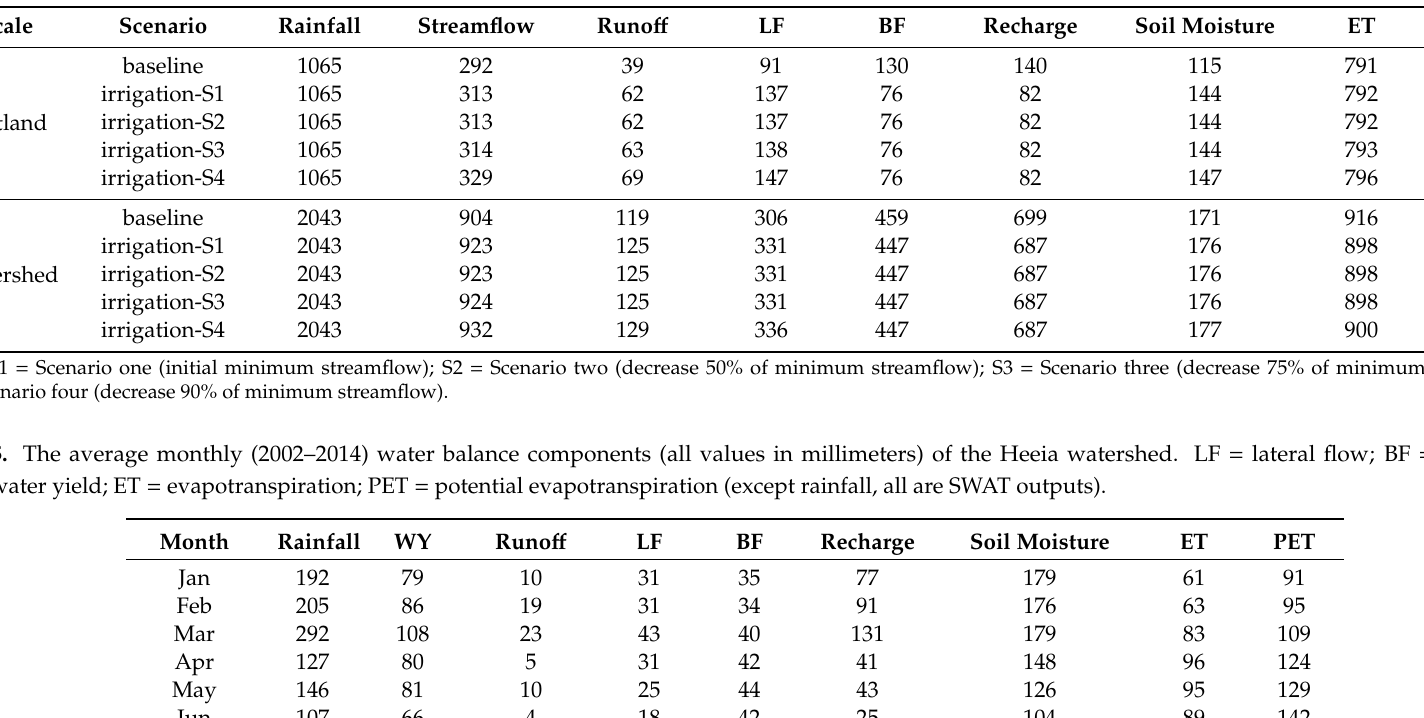
Table 4. The annual average of WBCs (all values in millimeters) for the Heeia wetland and watershed. LF = Lateral flow; BF = Base flow; ET = Evapotranspiration; PET = Potential Evapotranspiration (except rainfall, all are SWAT outputs).